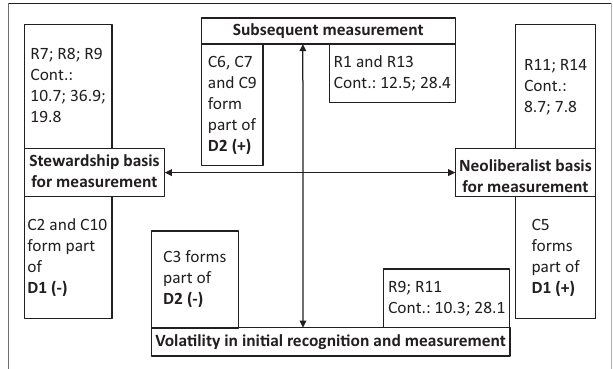
FIGURE 1: Correspondence